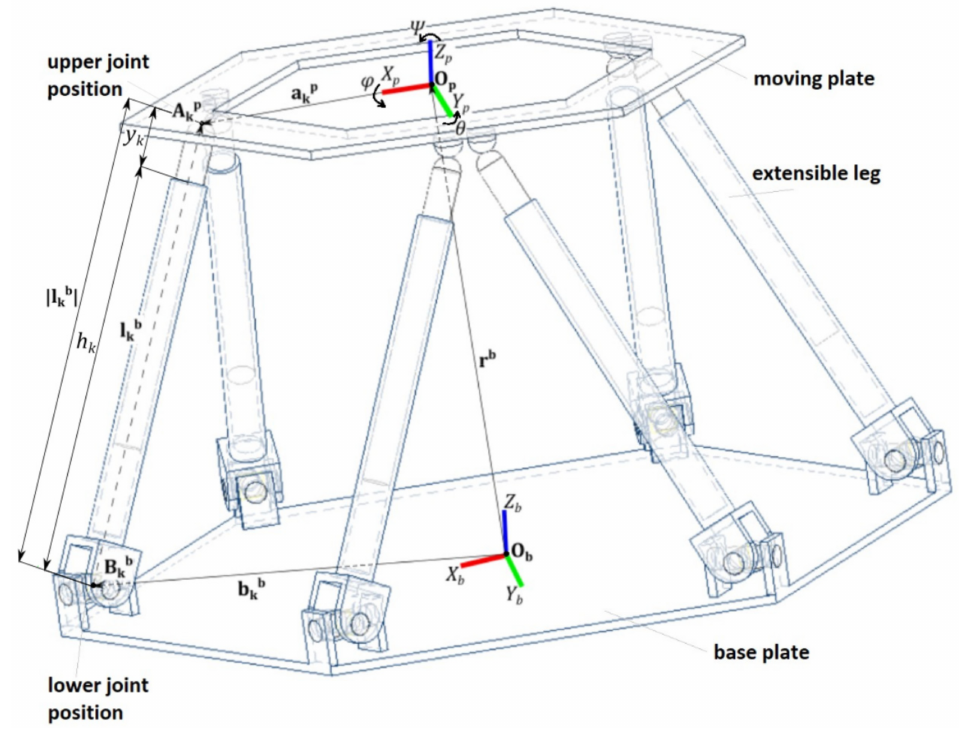
Figure 3. Schematic view of the general Stewart